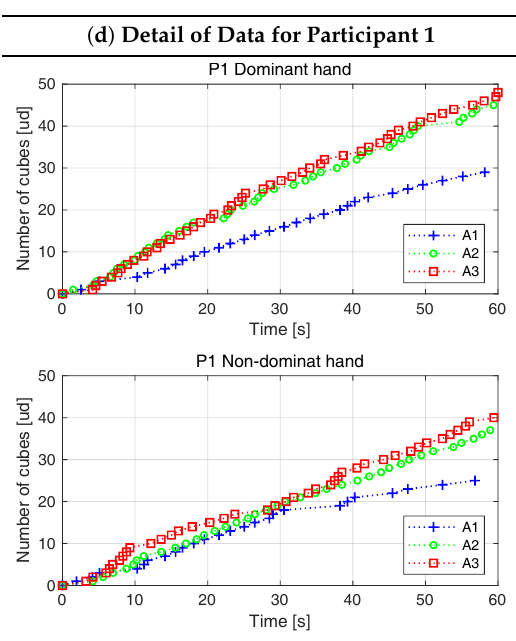
( d ) Detail of Data for Participant